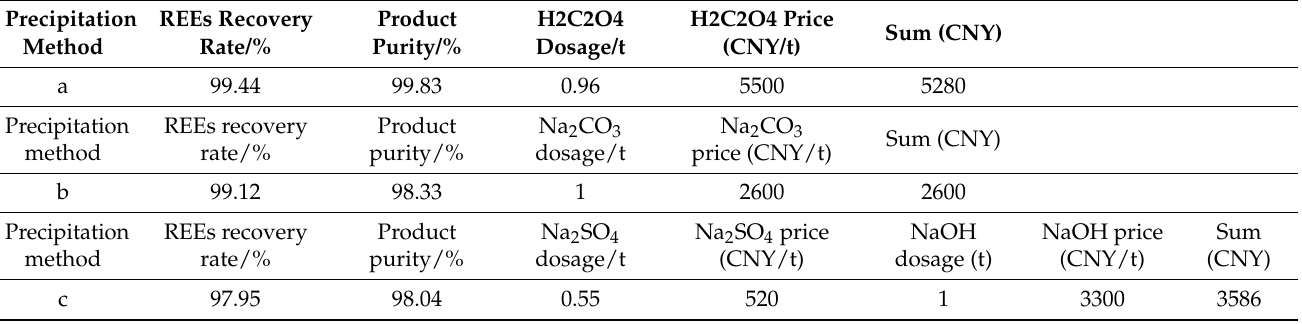
Table 3. Comparison of the three RE x O y oxide preparation methods.